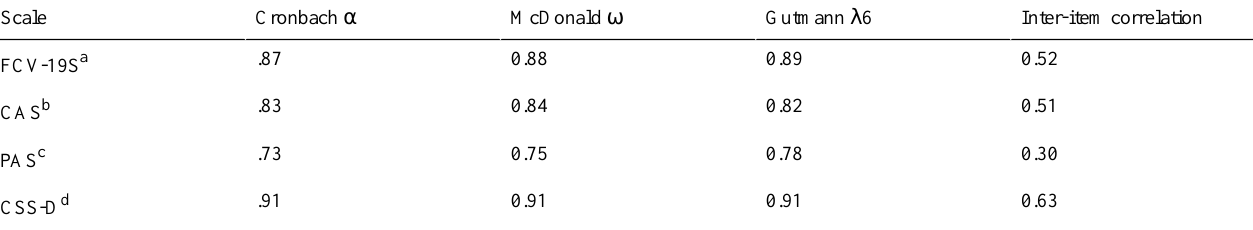
Table 3. Reliability of the COVID-19–related anxiety and distress scales